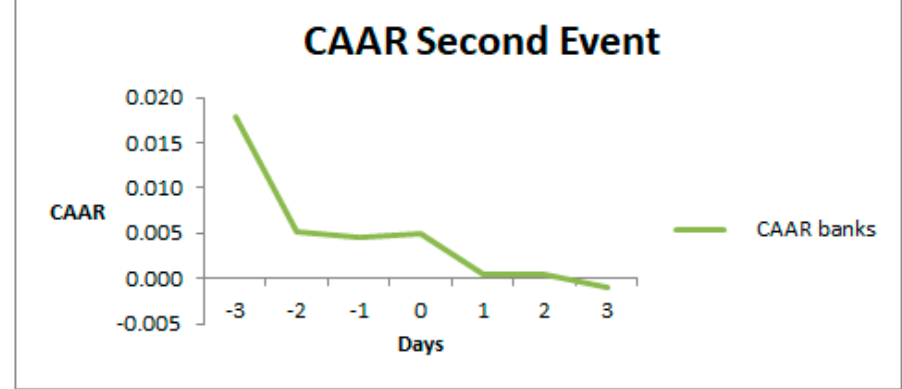
Figure A2. CAARs for banks associated with the second event. Source: Authors’ work.